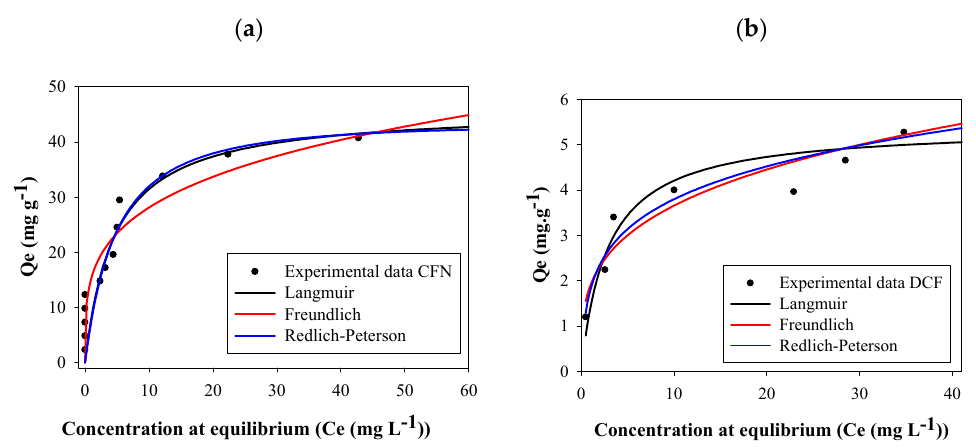
ff eine ( a ) (CFN) and diclofenac ( b ) (DCF) onto Figure 5. Adsorption isotherms of caffeine ( a ) (CFN) and diclofenac ( b ) (DCF) onto FB850-3. Figure 5. Adsorption isotherms of ca